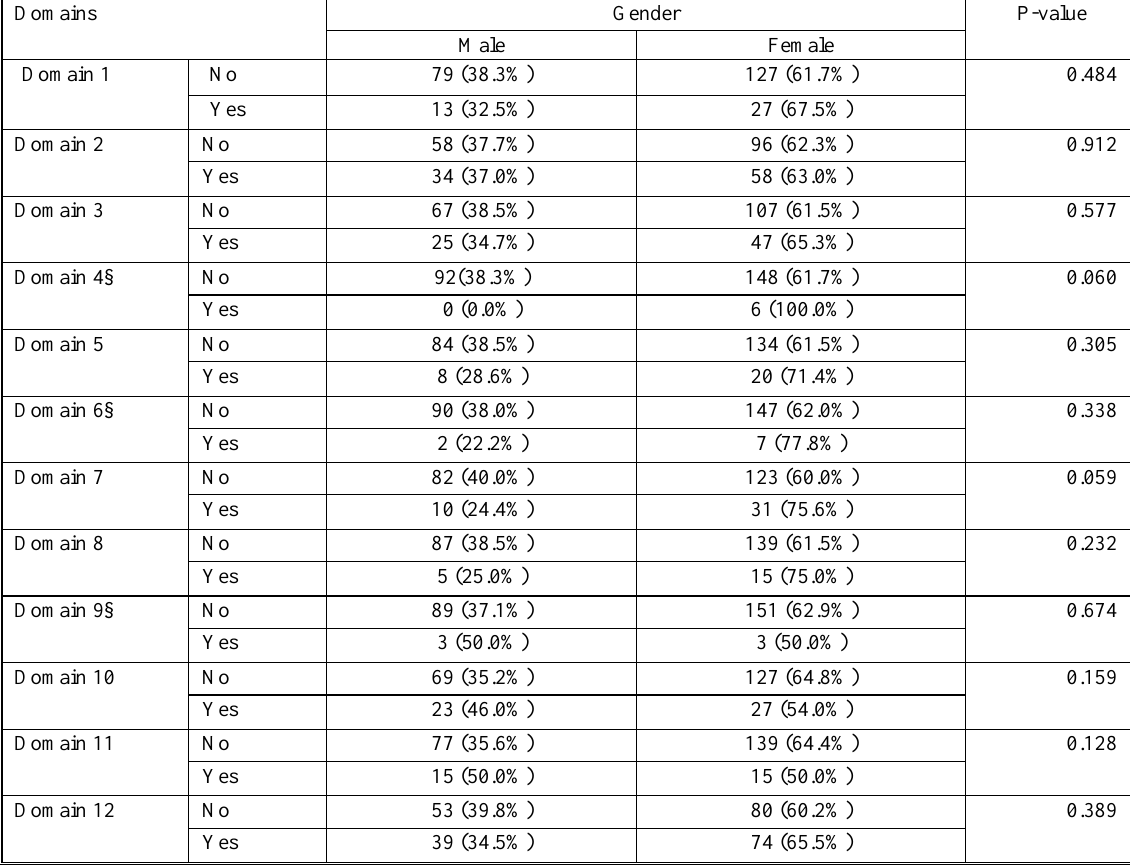
Table 4.The relationships between the patient gender and the study domains Domains